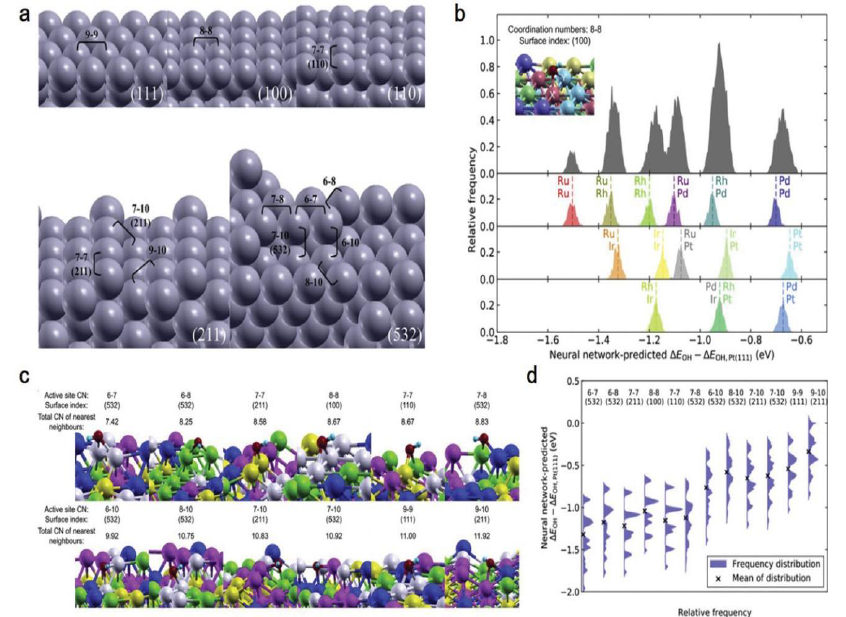
Figure 18. ( a ) Datasets of HEA surfaces and active sites were used for model training and evaluation. ( b ) The frequency distribution of OH* adsorption energies due to ligand effects for the [100] surface is shown as an example. ( c ) The different coordination environments are listed in increasing sequence of the total number of ligands in immediate proximity. ( d ) Frequency distributions of OH* adsorption energies for each ligand environment. (Reprinted with permission from [242]. Copyright 2021, John Wiley and Sons).